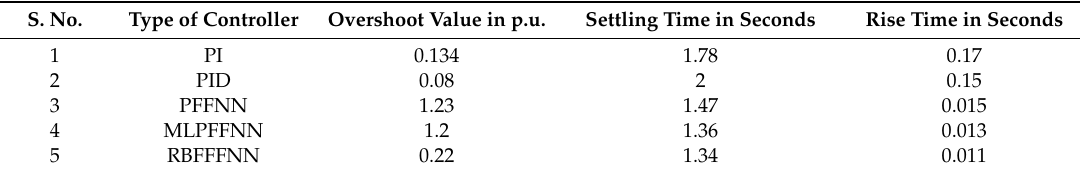
Table 4. Active power at rotor side.